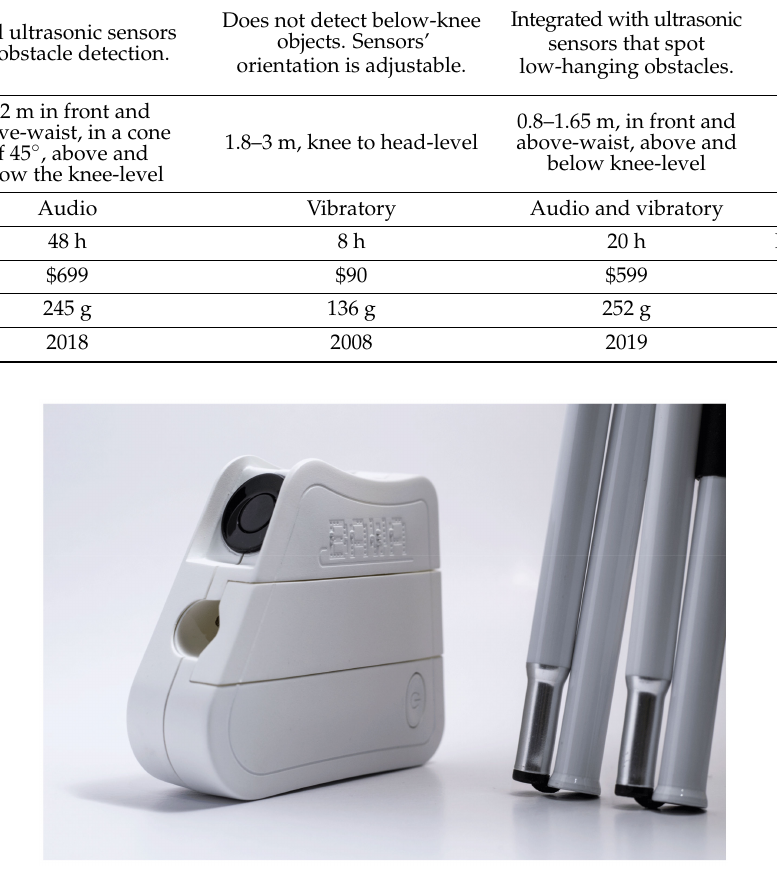
Figure 1. Stock photo of BAWA Cane [37].